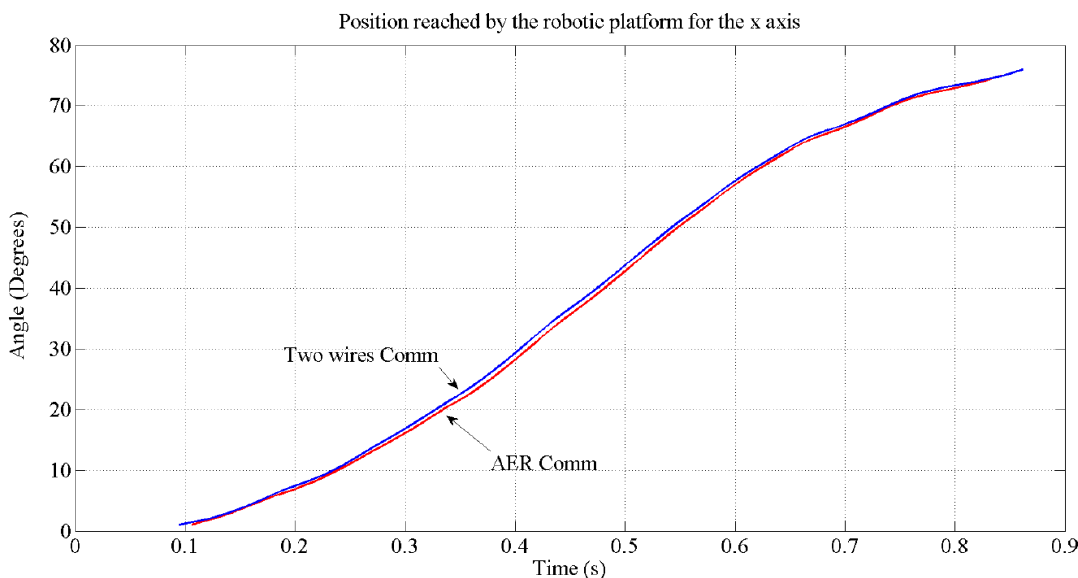
Figure 16. Position reached by the motors for the x-axis when two different communication strategies are